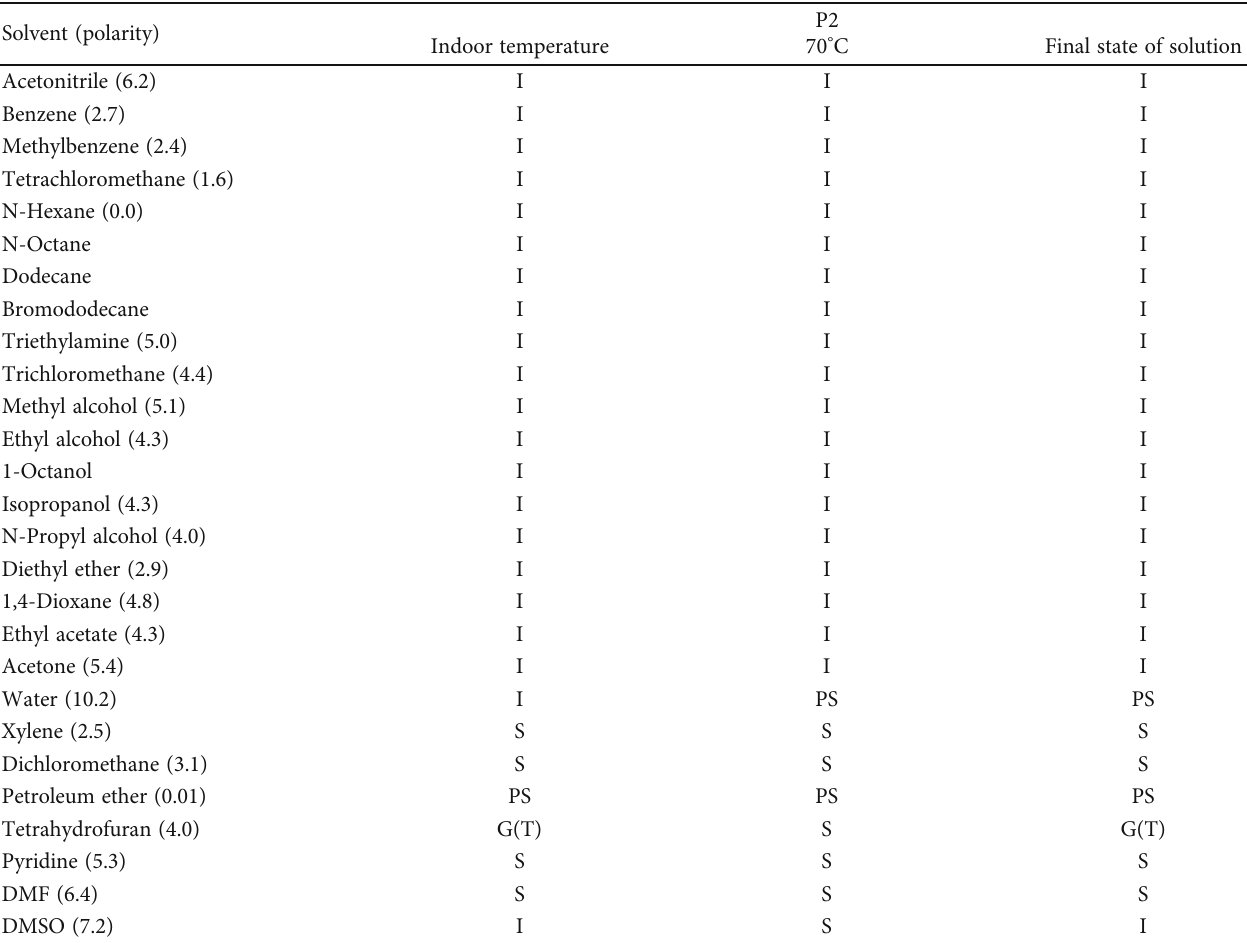
Table 10: Solvent gelation behavior of P2 in di ff erent organic